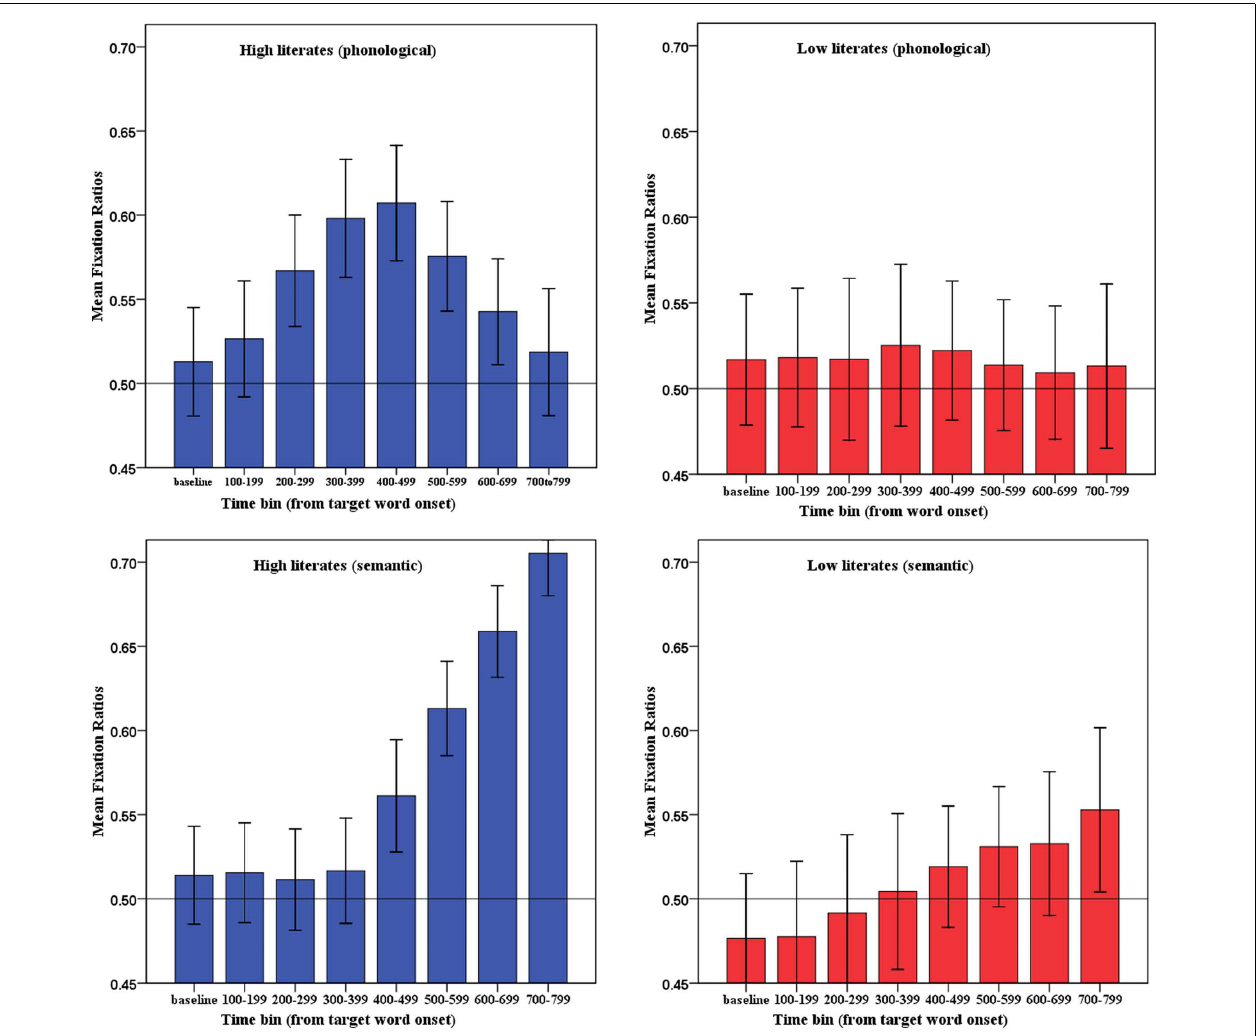
FIGURE 3 | Mean fixation ratios (upper panels: phonological; lower panels: semantic) in Experiment 1. Error bars represent 95% confidence intervals.